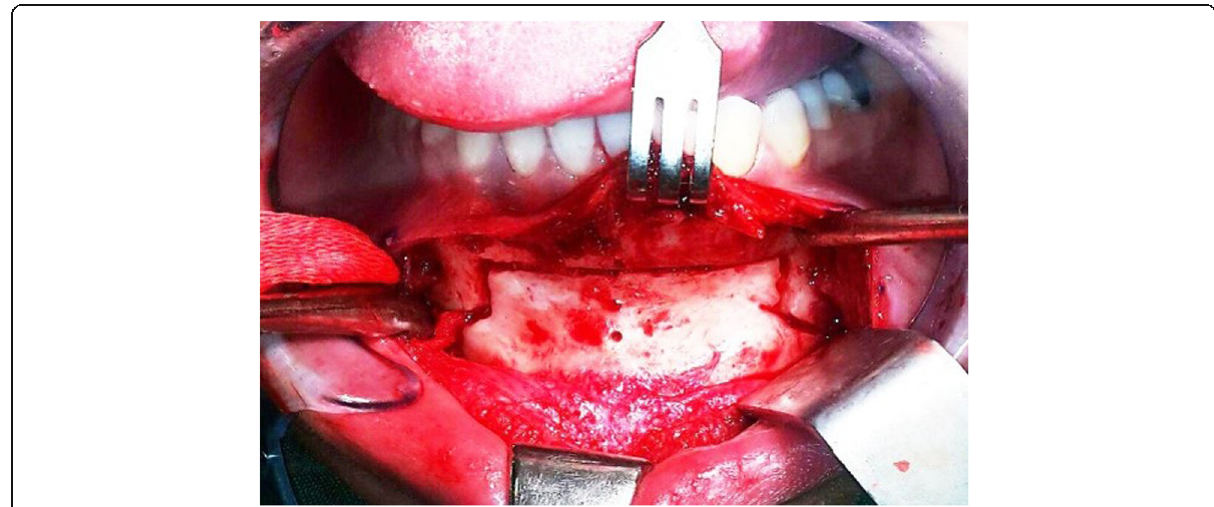
Fig. 2 Intra-operative view of Balcony